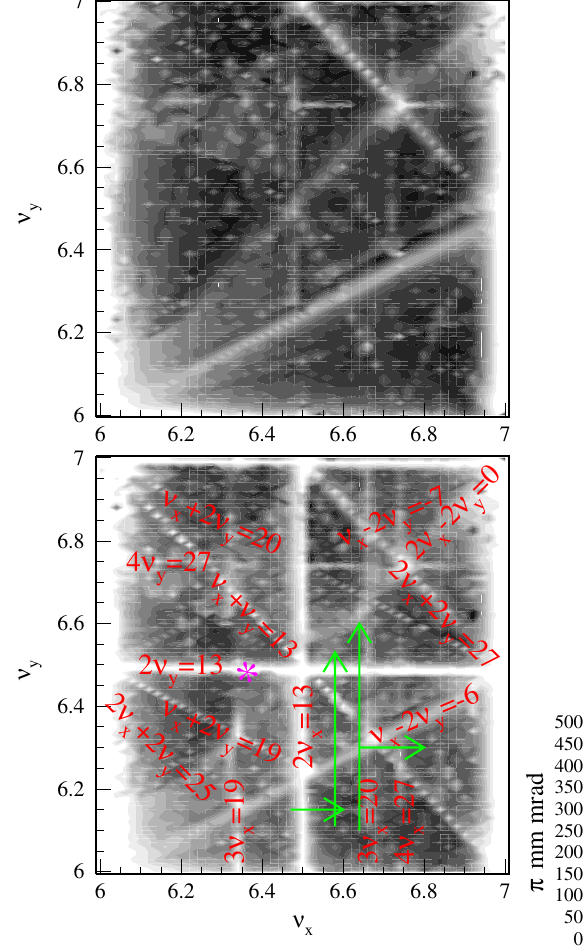
FIG. 17. (Color) Dynamic aperture maps obtained from single- particle tracking simulations without (upper) and with (lower) the leakage fields from the extraction DC